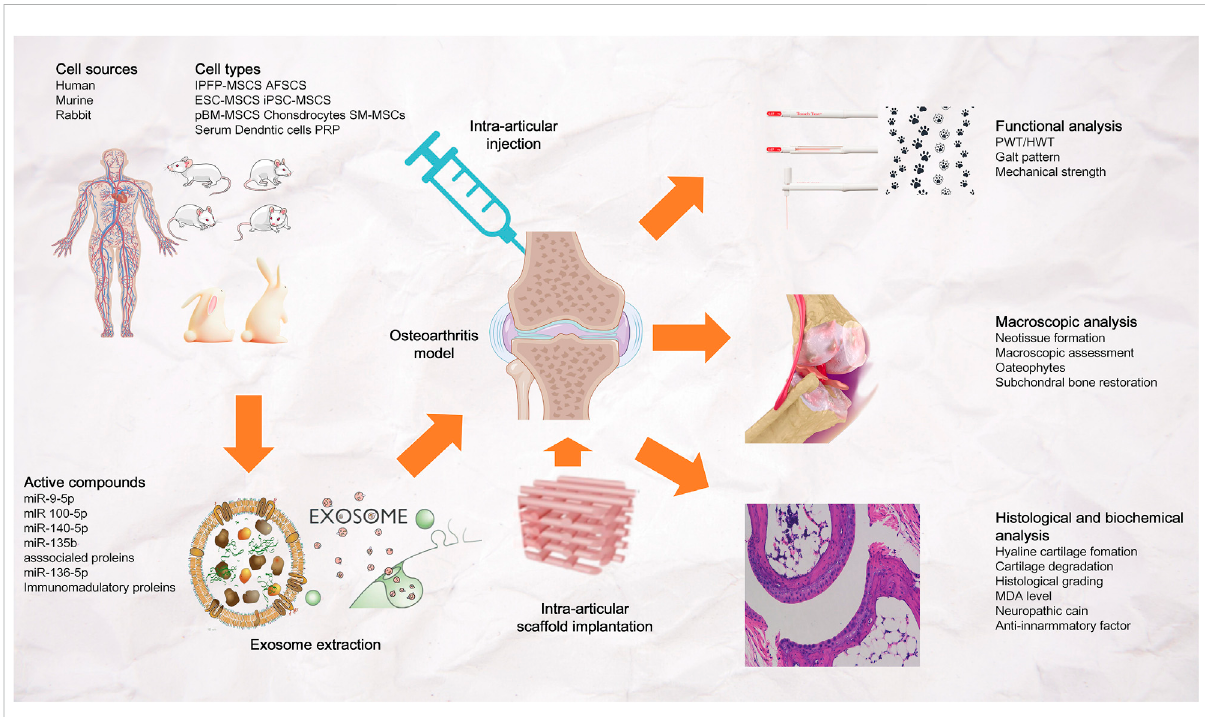
FIGURE 8 Exosomal bioactive compounds playan important role incartilage and subchondral bone repairandregeneration.The exosomes werederived fromhuman,murineorrabbitamniotic fl uidstemcells(AFSCs),embryonicstemcell-derivedmesenchymalstem/stromalcells(ESC-MSCs),induced pluripotent stem cell-derived MSCs (iPSC-MSCs), bone marrow-derived MSCs (BM-MSCs), polydactyly BM-MSCs, synovial